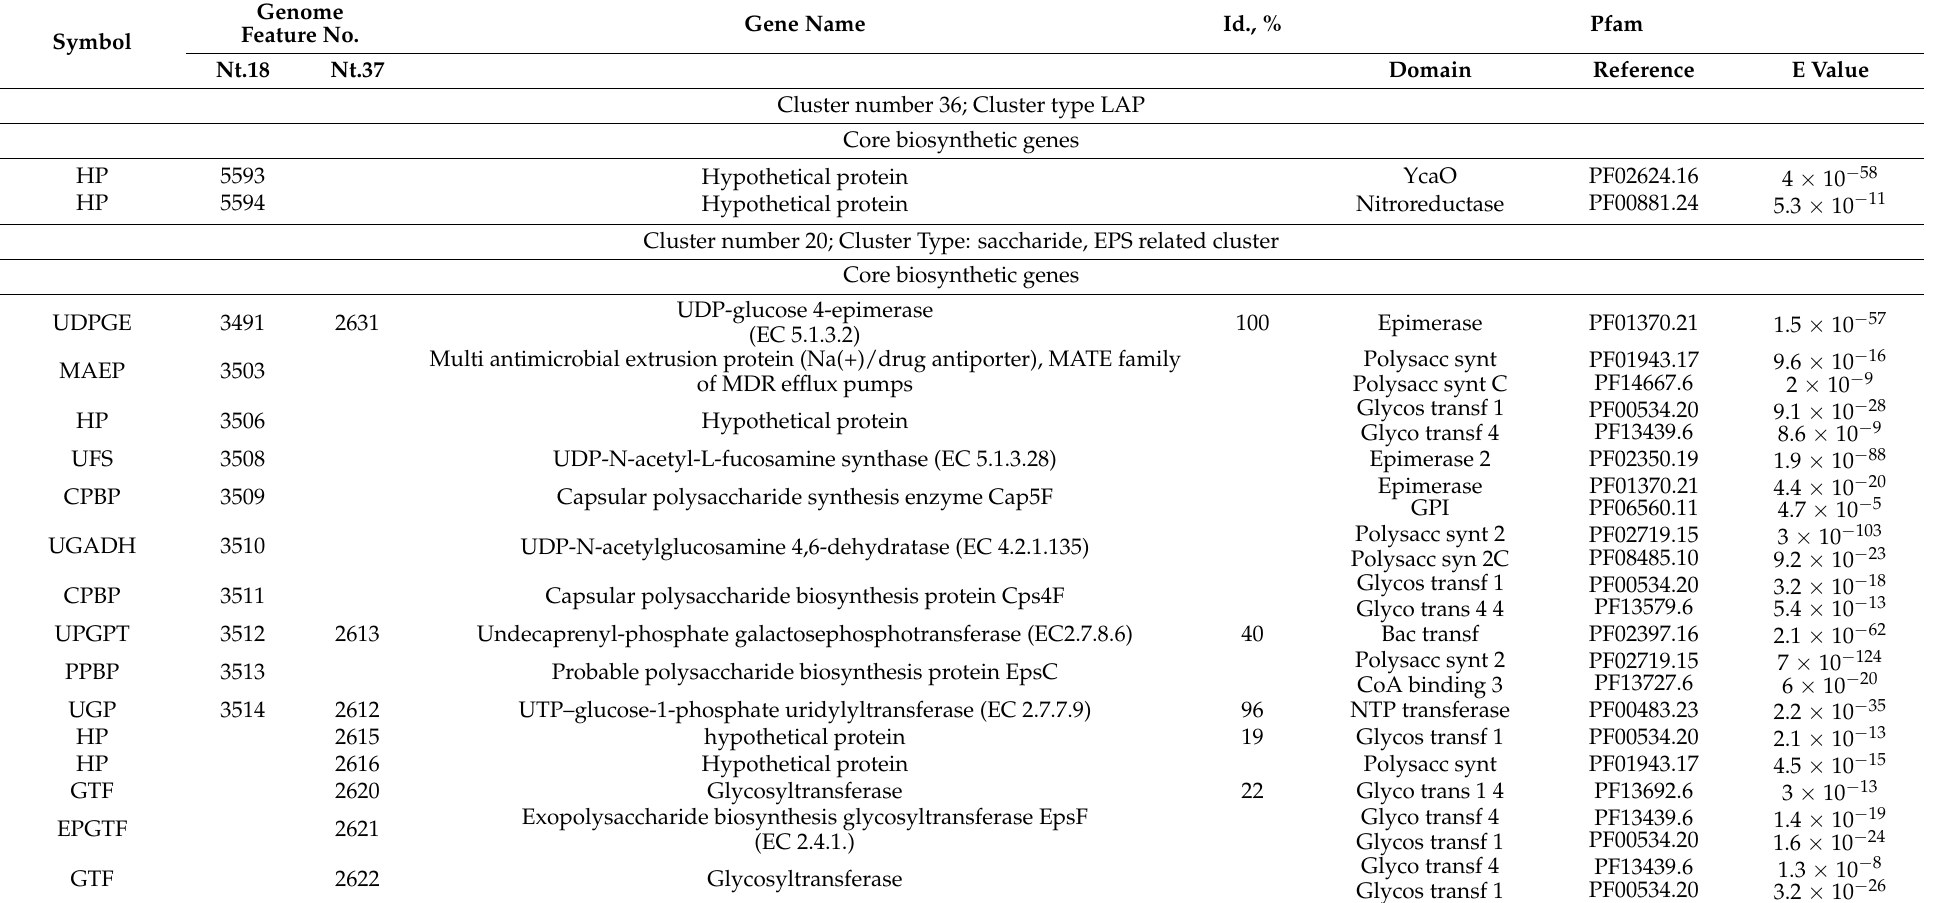
Table A5. Annotation results for secondary metabolite biosynthetic gene clusters No. 36 and 20 related to LAP and EPS biosynthesis, respectively, identified using the antiSMASH server. Feature number are indicated as in Supplementary Materials Tables S1 and